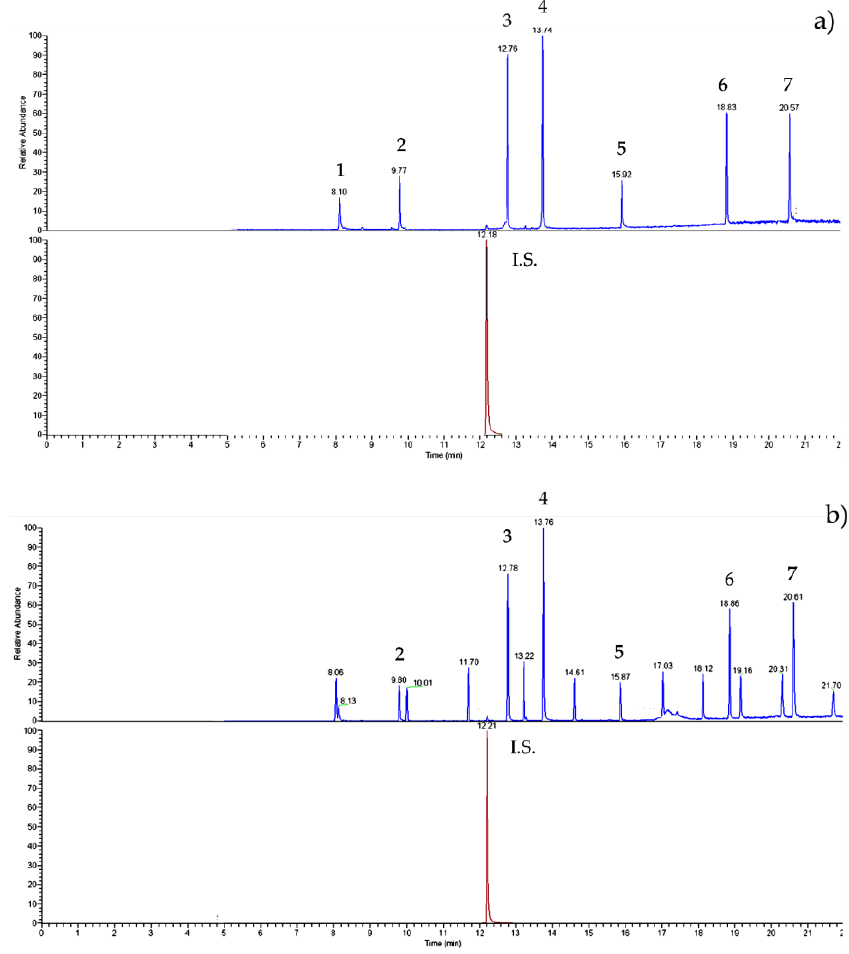
Figure 2. GC–IT/MS chromatograms of ( a ) PAE/BP-A (50 ng mL −1 of each) standard solution and ( b ) Figure 2. GC–IT / MS chromatograms of ( a ) PAE / BP-A (50 ng mL − 1 of each) standard solution and ( b ) nectar honey sample (#27). For experimental conditions, see text. Peak list: 1—DMP; 2—DEP; internal standard (I.S.)—phenanthrene; 3—DiBP; 4—DBP; 5—BP-A; 6—DEHP; 7—DnOP.